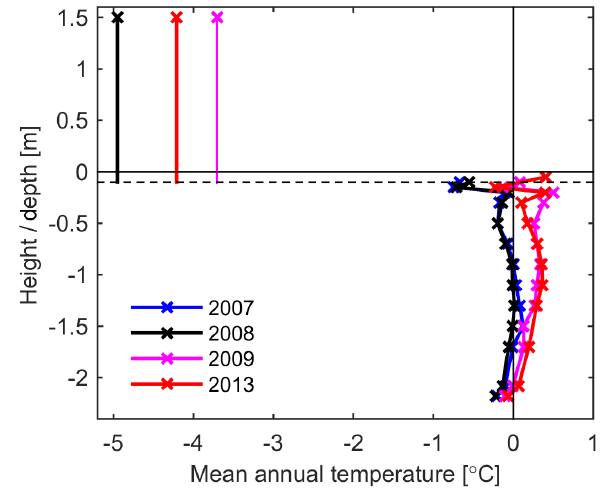
Figure 3. Relationship between the daily mean air temperature ( T a ) and near-surface soil temperature ( T 5cm , measured at 5cm below the ground surface) over the period from 2006 to 2014.